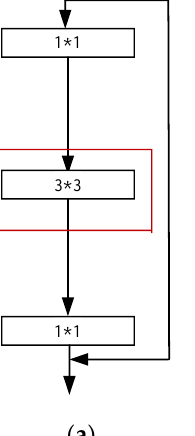
Figure 5. SE module structure.